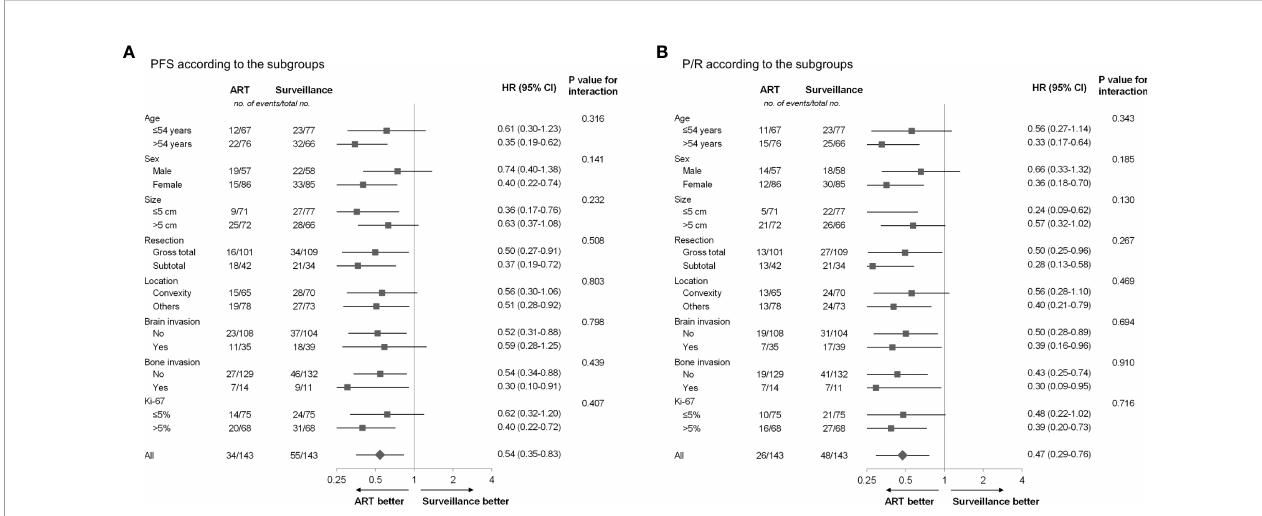
FIGURE 3 | (A) PFS and (B) P/R according to subgroup in the propensity score-matched cohort. ART, adjuvant radiotherapy; PFS, progression-free survival; P/R, progression/recurrence.